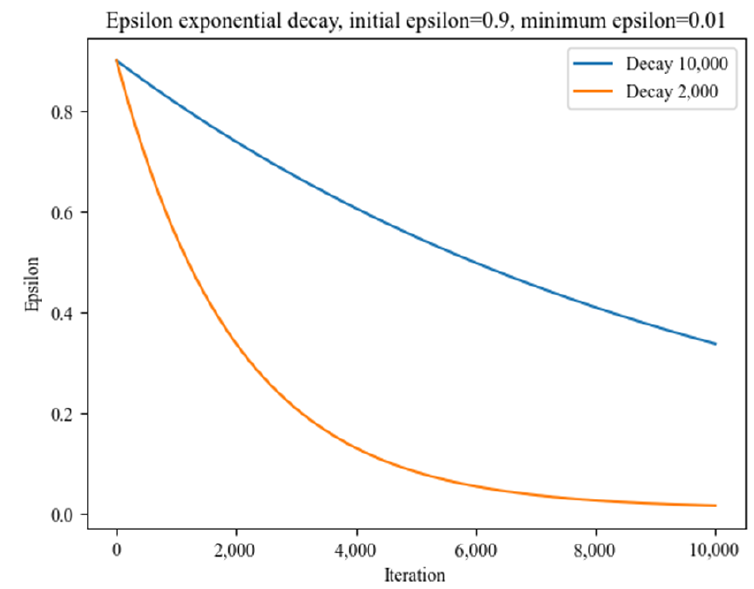
Figure 6. Impact of epsilon decay on the rate of epsilon values.